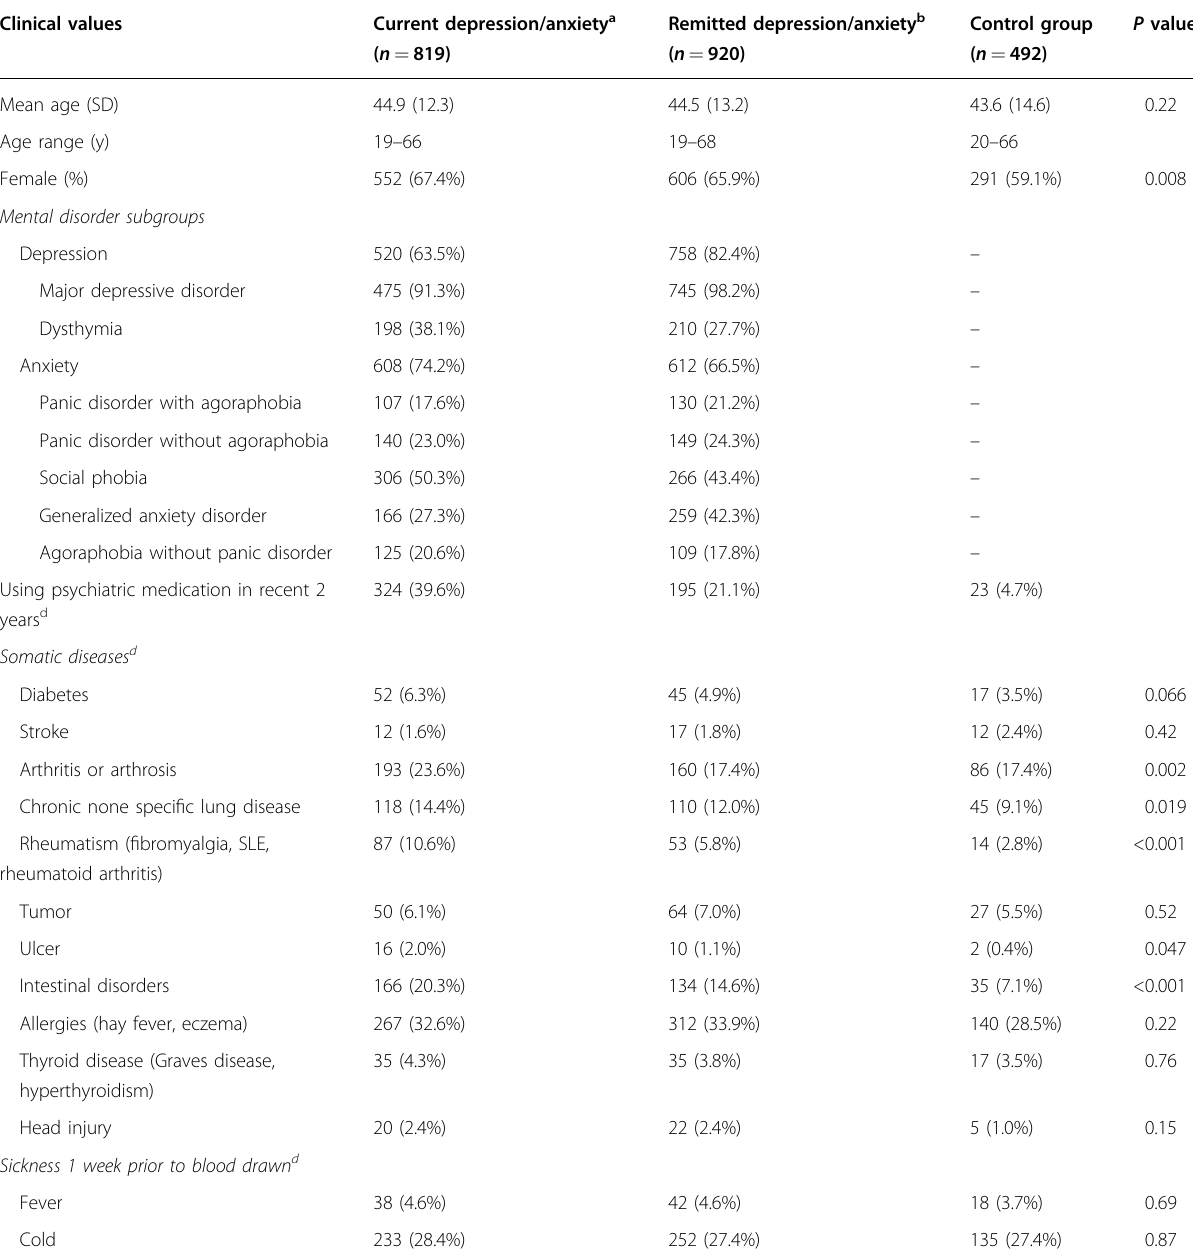
Table 1 The demographic characteristics of the NESDA cohort (at the 2-year follow-up). Clinical